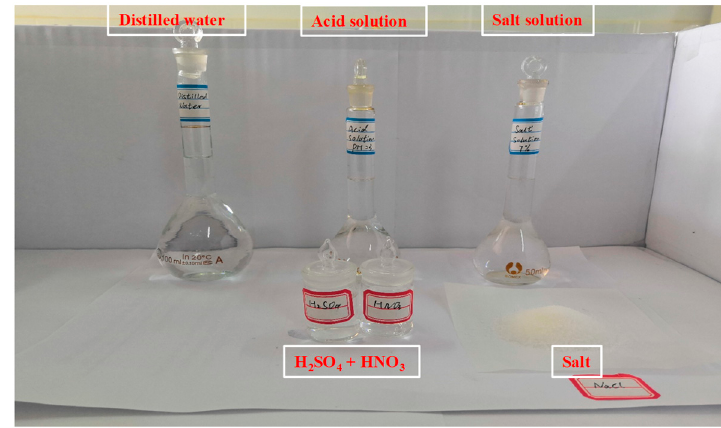
Figure 1. Simulated environment reagents.